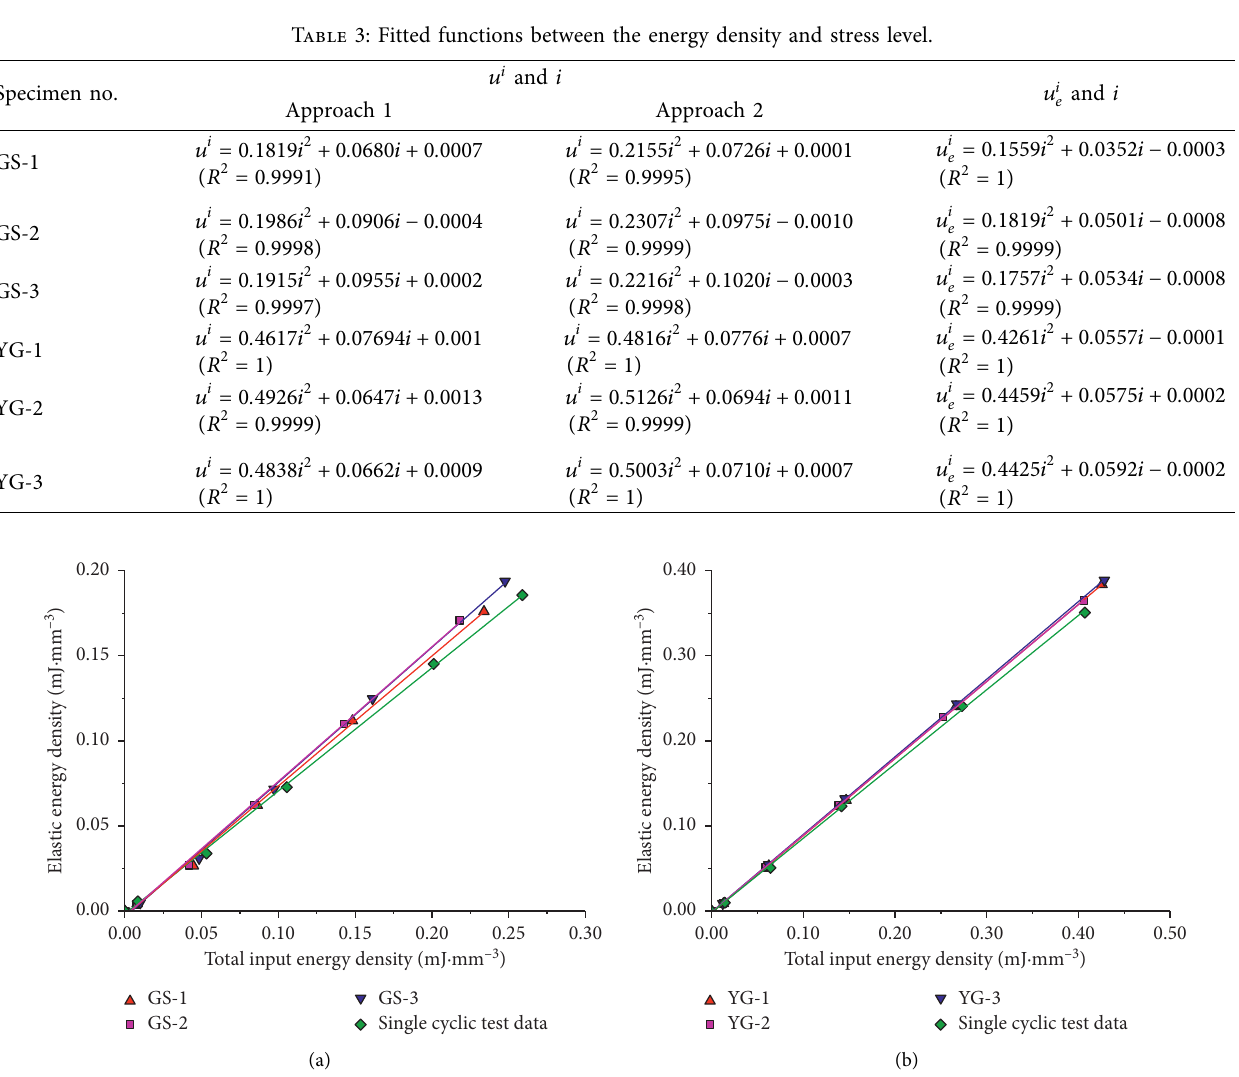
Figure 9: Relationship between the elastic and total input energy density of rock specimens in approach 1. (a) Green sandstone; (b) Yueyang